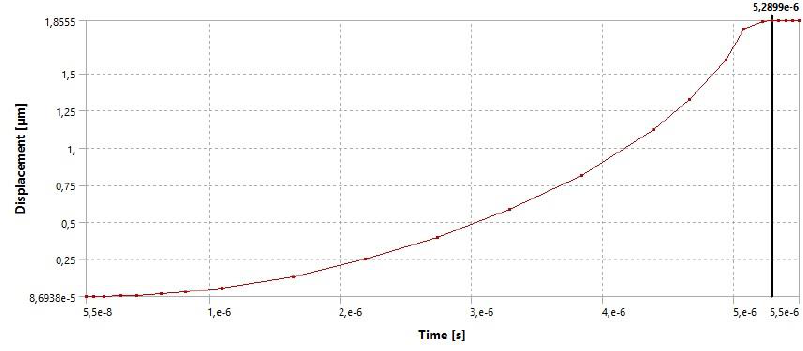
Fig. 7. The dependence of the MEMS membrane displacement of the switch on